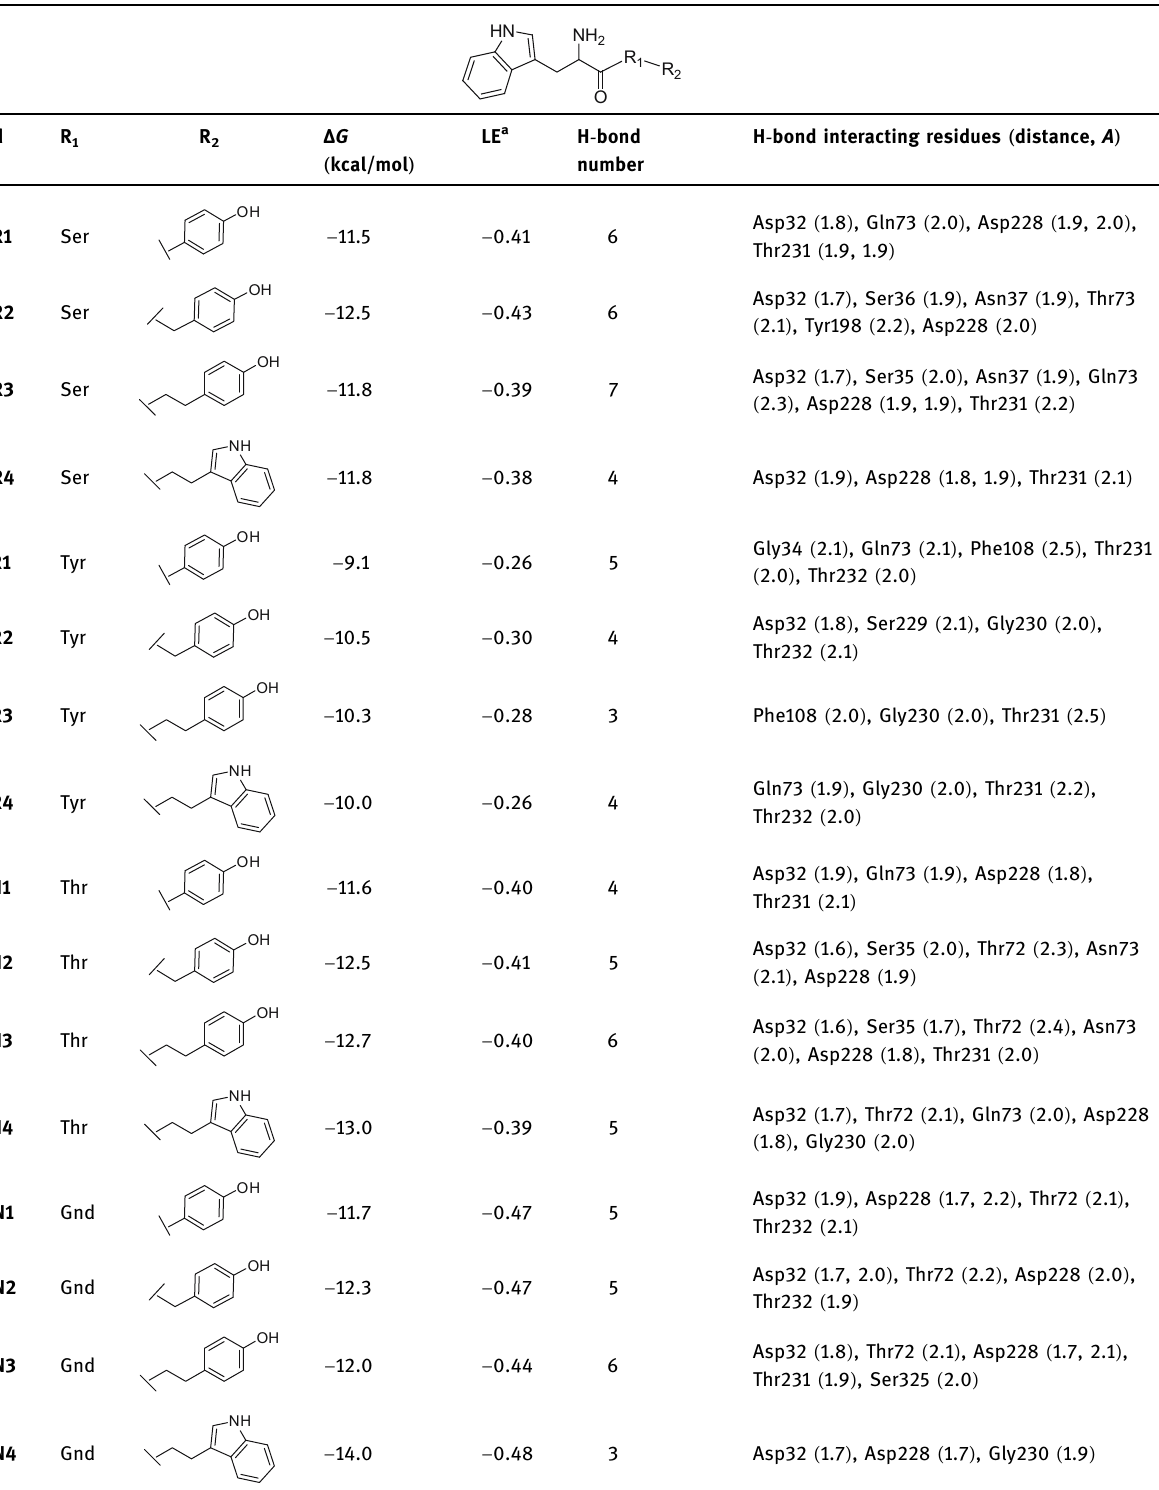
Table 1: Docking results of the designed compounds against the BACE1 template